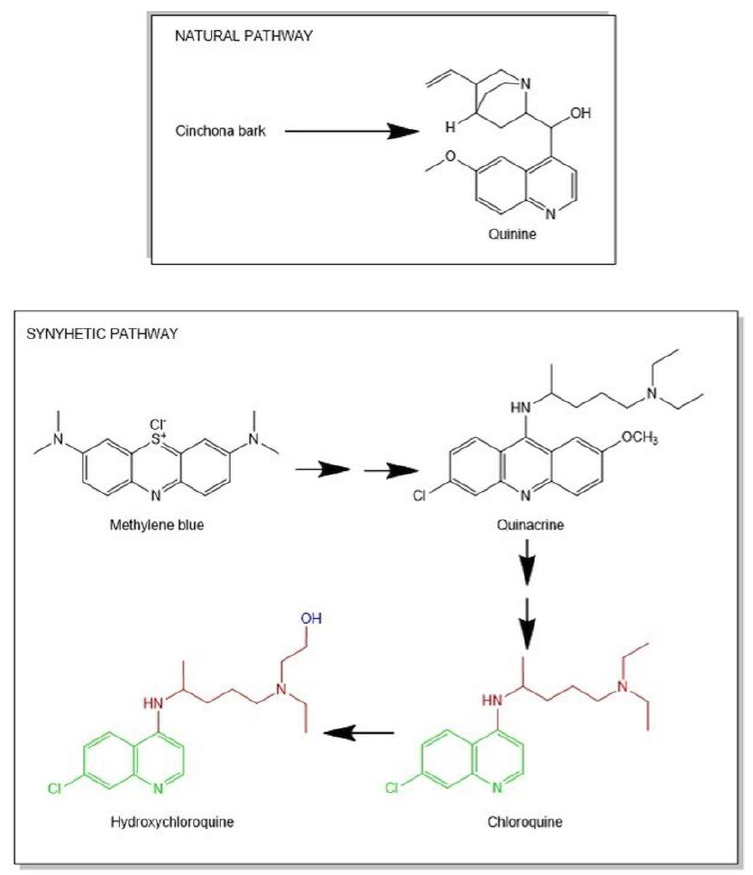
Figure 1. Historical development of hydroxychloroquine (HCQ) synthesis. In green is represented the 4-aminoquinoline nucleus, in red is the amphiphilic weak basic side chain and in blue, the hydroxyl group.